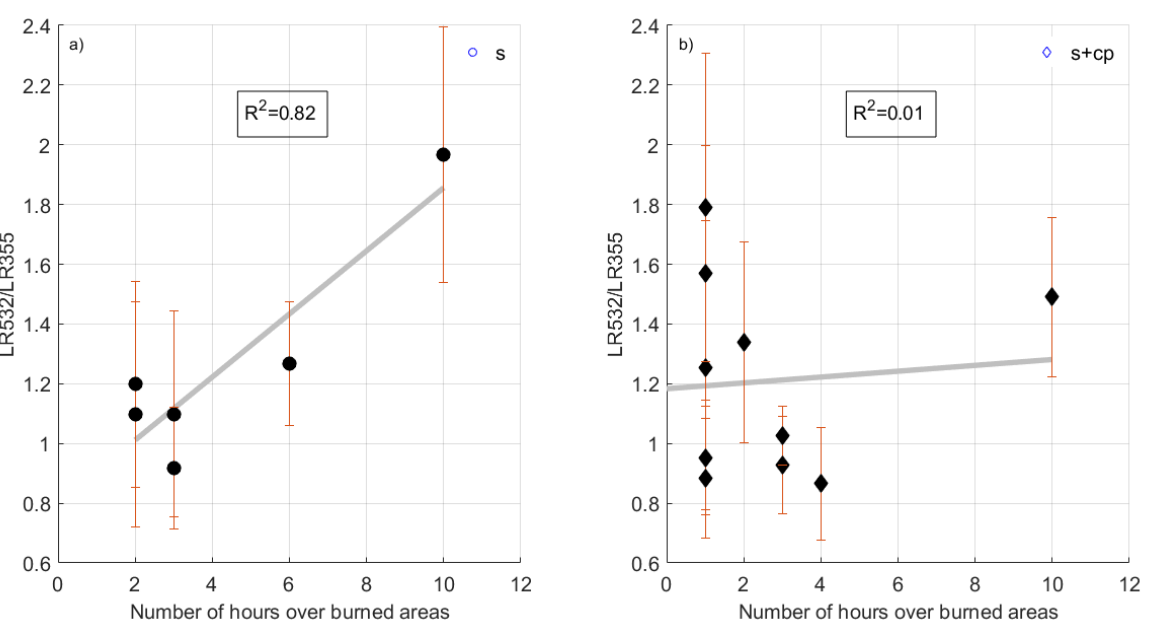
Figure 3. Correlation between the variables LR532/LR355 and number of hours over burned areas for ( a ) the s aerosol layers; ( b ) the s+cp aerosol layers.